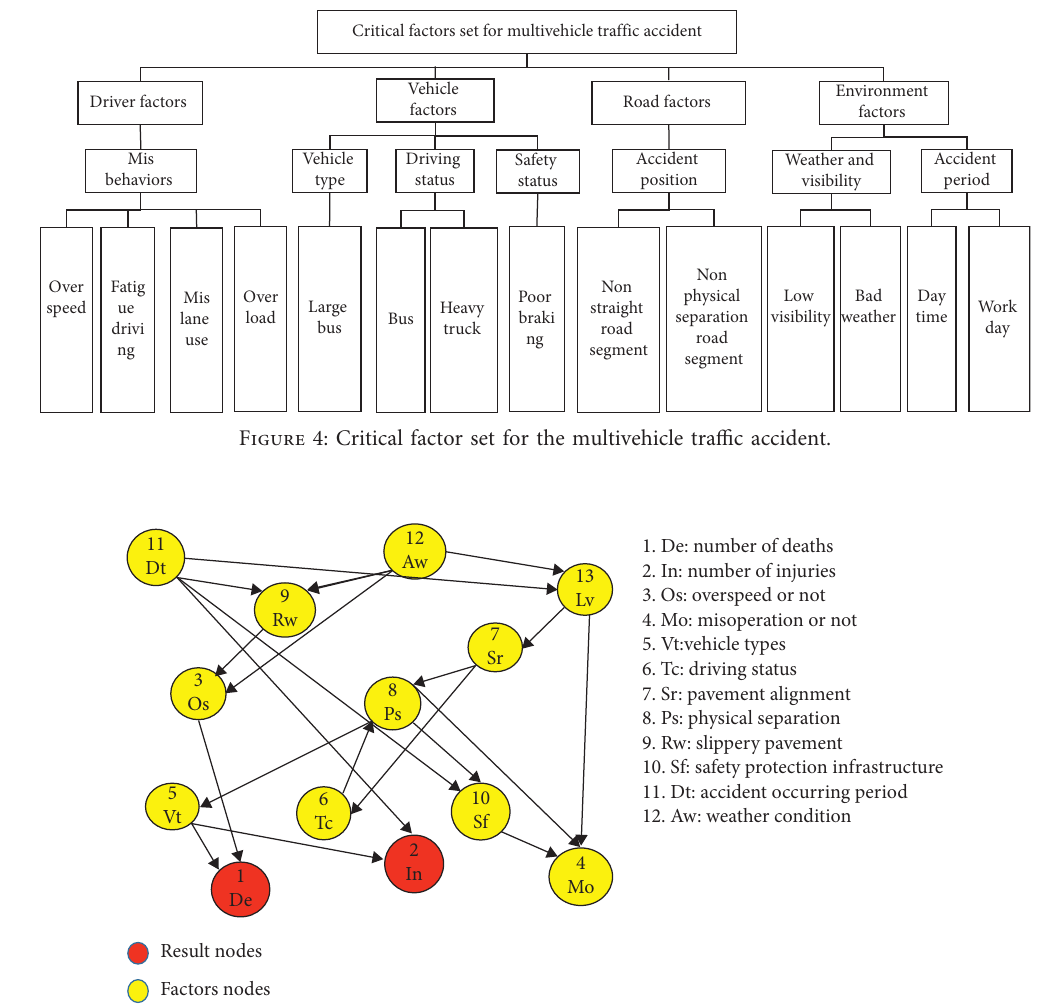
Figure 5: Preliminary learning result of single-vehicle traffic accident network.